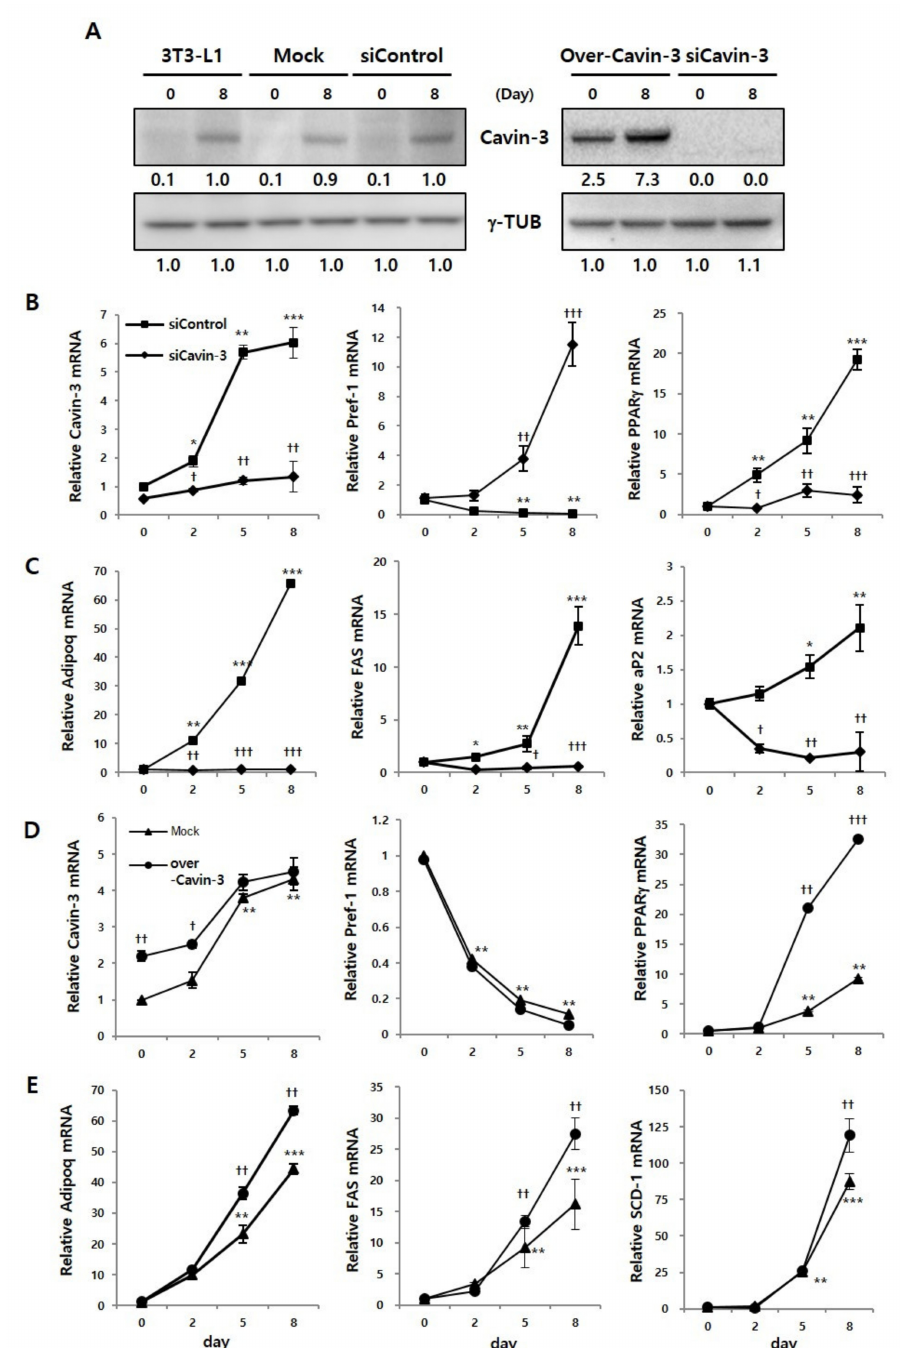
Figure 2. Cavin-3 gene modulation influences adipogenesis-related mRNA expressions. ( A ) Expression of Cavin-3 protein was validated in 3T3-L1 adipocytes, siControl, siCavin-3, Mock, and over-Cavin-3 cells by Western blot analysis at days 0 and 8 of di ff erentiation. γ -TUB was used as a control and the grouping of blots cropped from di ff erent gels. ( B – E ) The mRNA expression of Cavin-3, preadipocyte factor 1 ( Pref-1 ), peroxisome proliferator-activated receptor gamma ( PPAR γ ), adiponectin ( Adipoq ), fatty acid synthase ( FAS ), adipocyte protein 2 ( aP2 ), and stearoyl-CoA desaturase ( SCD-1 ) in siControl ( n = 3) vs. siCavin-3 ( n = 3) and Mock ( n = 3) vs. over-Cavin-3 ( n = 3) cells, respectively. The expression levels were determined by RT-qPCR at various time points (0, 2, 5, and 8 days of di ff erentiation). The data are presented as the means ± SD. (* p < 0.05, ** p < 0.01, *** p < 0.001 compared to siContol or Mock at day 0: † p < 0.05, †† p < 0.01, ††† p < 0.001 compared to siControl or Mock at each time point; data were analyzed with an unpaired Student’s t